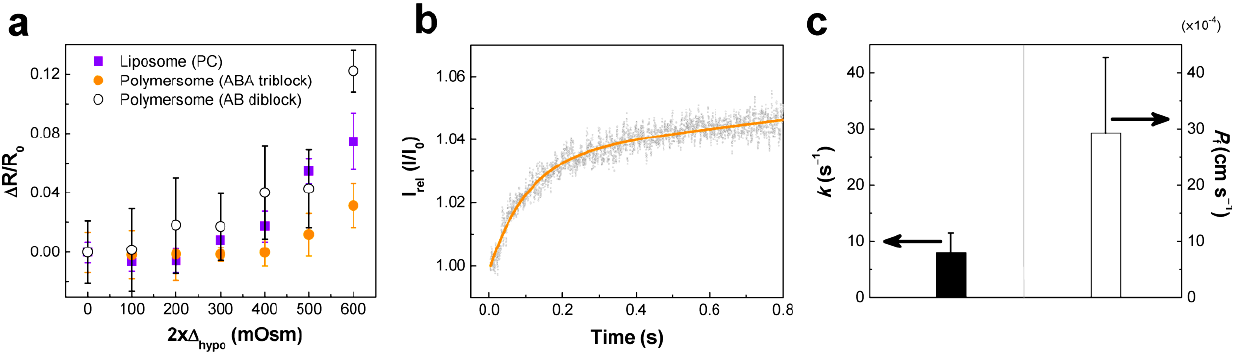
Figure 4. Membrane characteristics of polymersomes. ( a ) Relative swelling of PC-liposomes, ABA polymersomes, and AB polymersomes at hypo-osmotic stresses; ( b ) Hyperosmotic stress-induced stopped-flow light scattering of polymersomes at 300 mOsm of hyper-osmotic stress and 4 °C, and ( c ) their corresponding rate constant ( k [s −1 ]) and osmotic water permeability coefficient ( P [cm·s −1 ]). The hypo-osmotic stress-induced size change was f characterized using dynamic light scattering at 4 °C and the relative size change (∆ R / R = ( R – R )/ R , R and R are the radii at hypo-osmotic (∆ ) and iso-osmotic 0 0 0 0 hypo conditions, respectively) was plotted against 2∆ · k was measured by curve fitting of hypo light scattering spectra shown in ( b ) using the equation I = a + b∙e – k ∙ t , where a and b are constants. P was calculated by P = k ∙ V / A ∙ V ∙∆, where k = rate constant, V = initial f f 0 w 0